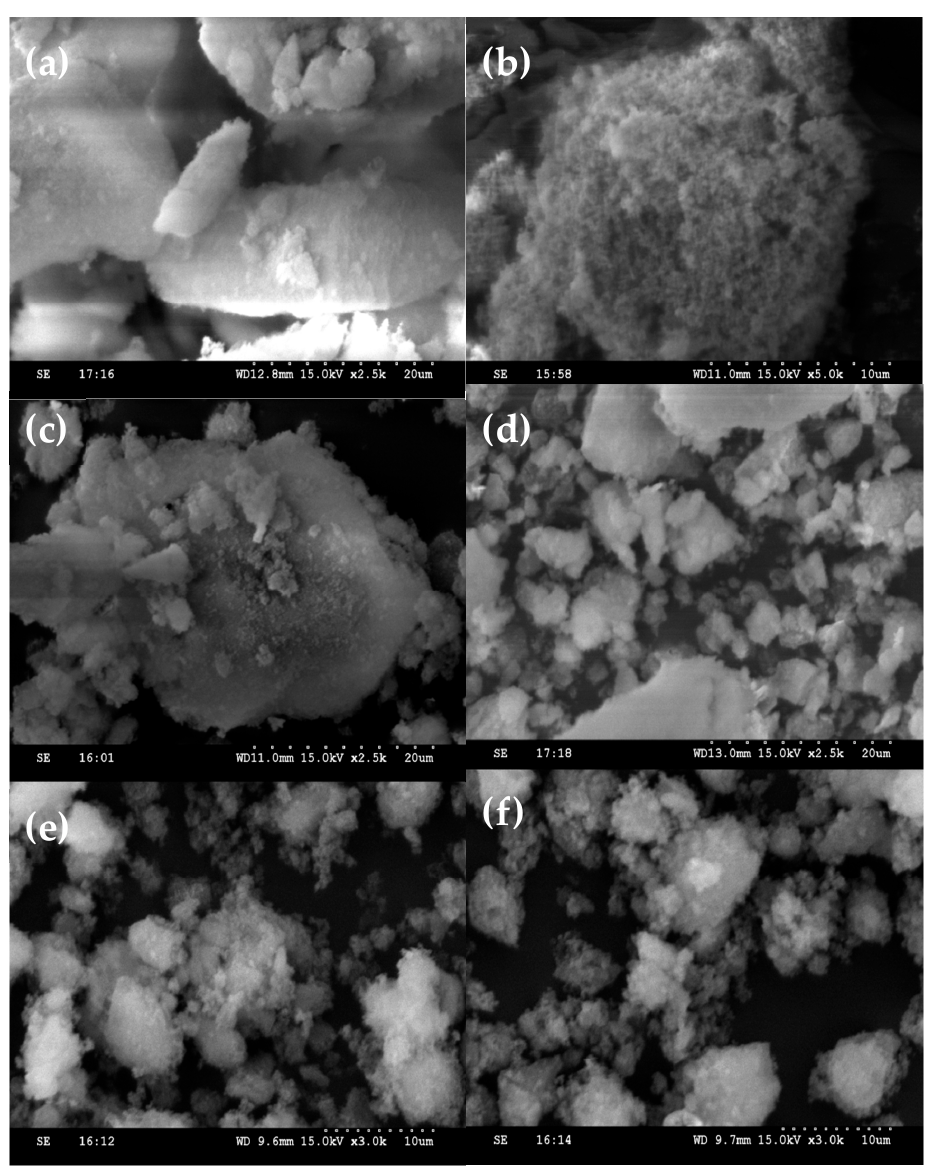
Figure 6. SEM images of pristine SiO 2 ( a ), 2 wt% ( b ), 5 wt% ( c ), 10 wt% ( d ), 15 wt% ( e ), 20 wt% ( f ) of Cu/SiO 2 catalysts.